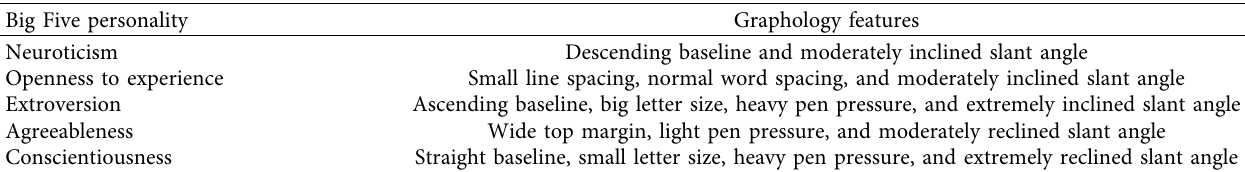
Table 9: Correlation between the Big Five model and graphology features.